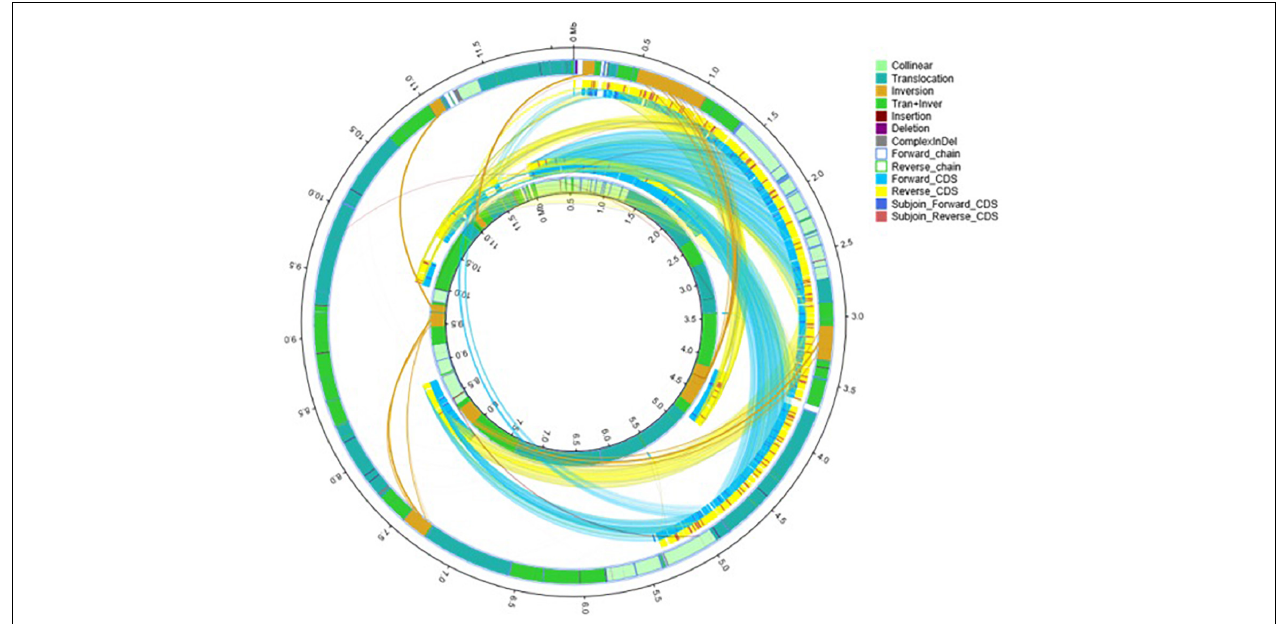
FIGURE 3 | Detailed circular genome diagram between the genomes of strains JH301 and S288c. The outer circle denotes the characteristics of the entire genome of strain JH301, and the inner circle denotes strain S288c.